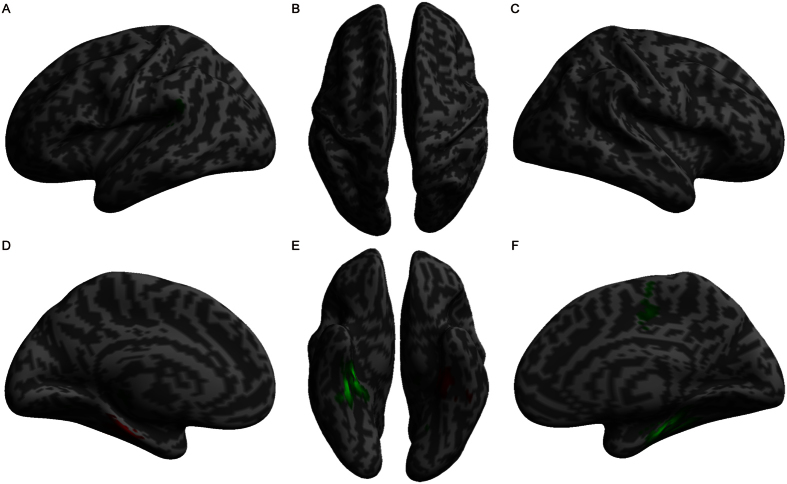
Volumetric differences between left and right UHL.The red color indicates increased gray matter volume, and the green color indicates decreased gray matter volume in left UHL patients compared to right UHL patients.